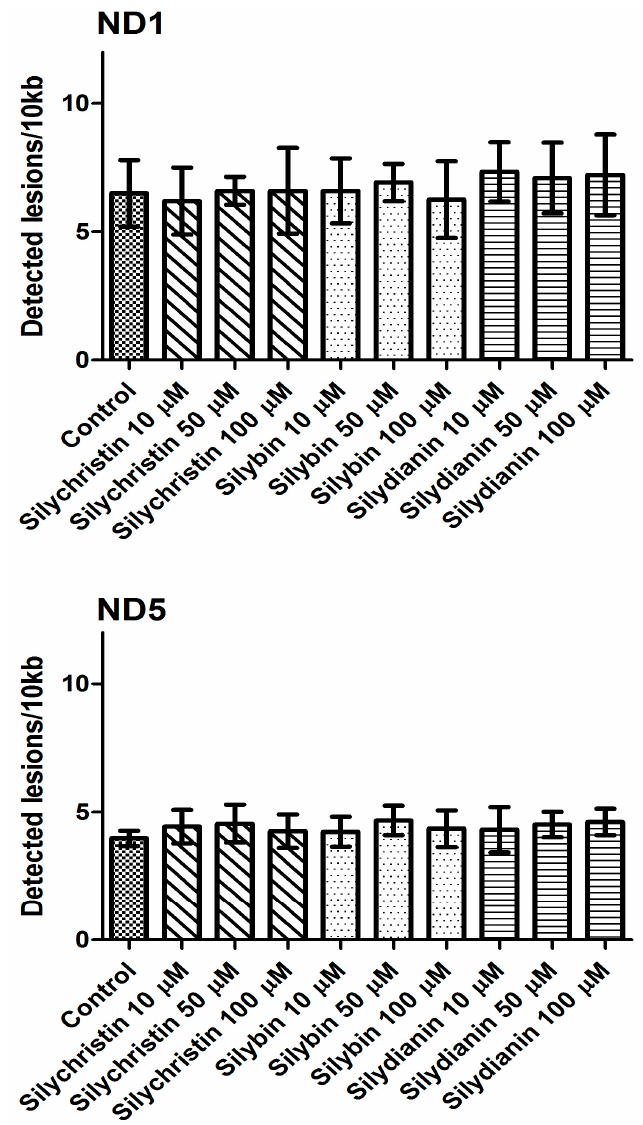
Figure 7. The effect of flavonolignans (silychristin, silybin and silydianin in concentrations of 10, 50 and 100 µM) on mitochondrial DNA (mtDNA) lesion frequency per 10 kb DNA in ND1 and ND5 genes, estimated by SLR-qRT-PCR amplification of total DNA from A549. The data represent means of ± SD, n = 8.